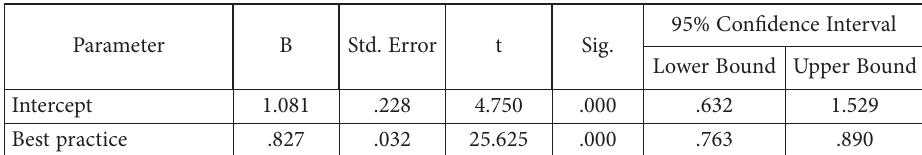
Table 7. Parameter estimates (Dependent Variable: Teamwork climate, employee turnover) (source: own research) Parameter B Std. Error t Sig. Intercept 1.081 .228 4.750 .000 .632 1.529 Best practice .827 .032